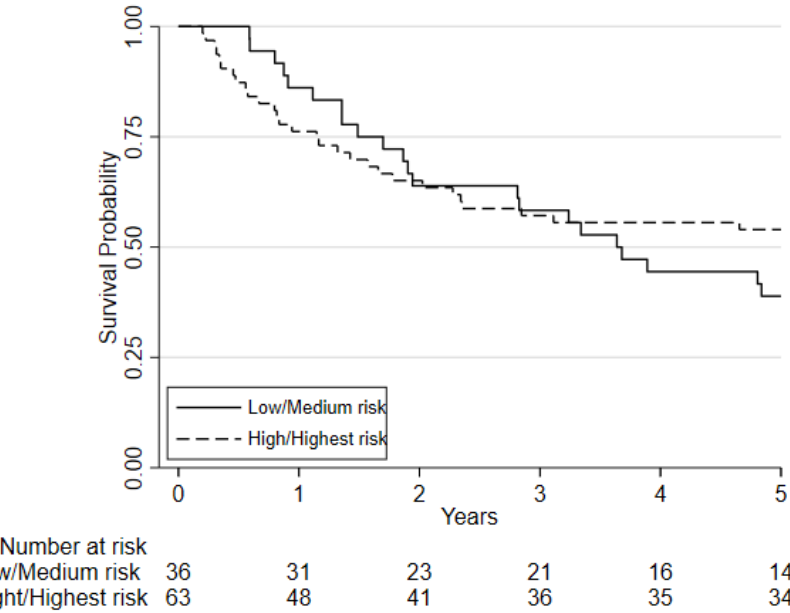
Figure 7. Kaplan-Meier plot of the estimated overall 5-year survival estimates among patients with oesophageal, esophagogastric-junction and gastric cancer who underwent CPET pre-and post-chemotherapy or chemoradiotherapy (NAC/ CRT) followed by surgery. Patients are split based on their post-NAC/CRT VO2 at AT using predefined risk stratification categories (low risk VO2 at AT >14ml.kg.-1min-1, medium risk VO2 at AT 11.0-14.0ml.kg-1.min-1, high-risk VO2 at AT 8.0-10.9ml.kg-1.min-1, highest risk VO2 at AT